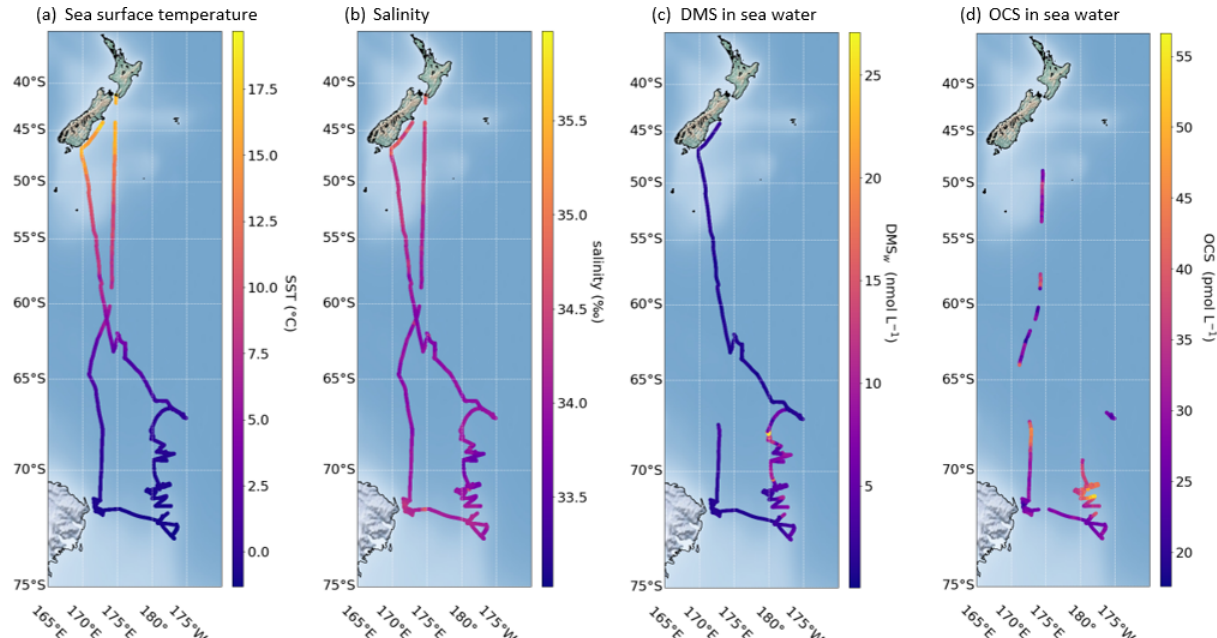
Figure 6. The track of the RV Tangaroa during the Southern Ocean Ross Sea Marine Ecosystem and Environment voyage (a) sea surface temperature, (b) salinity, (c) DMS measured in seawater, and (d) OCS measured in seawater. The measurements of DMS and OCS